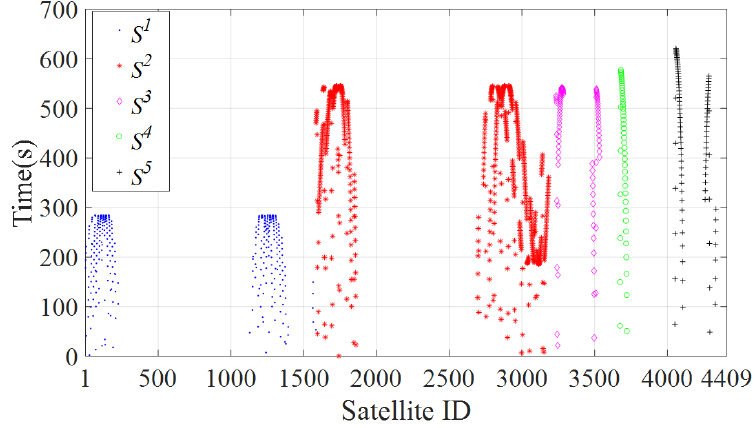
Figure 9. Coverage time of satellites.